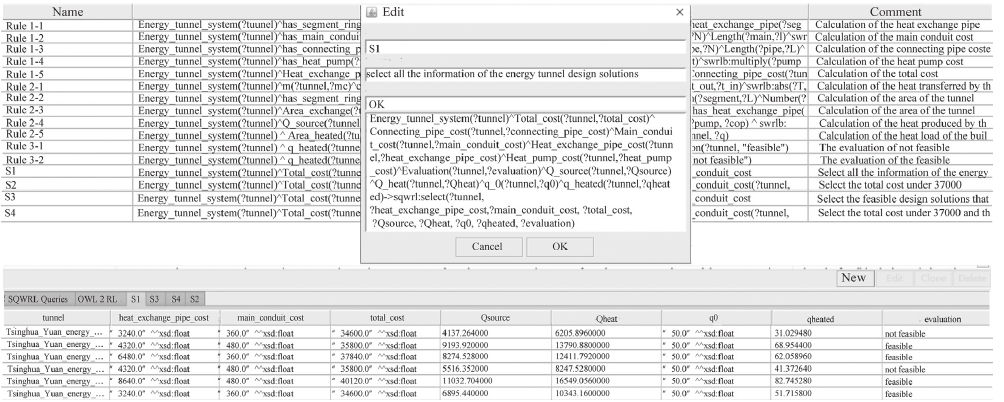
Figure 9: Execution and results of Table